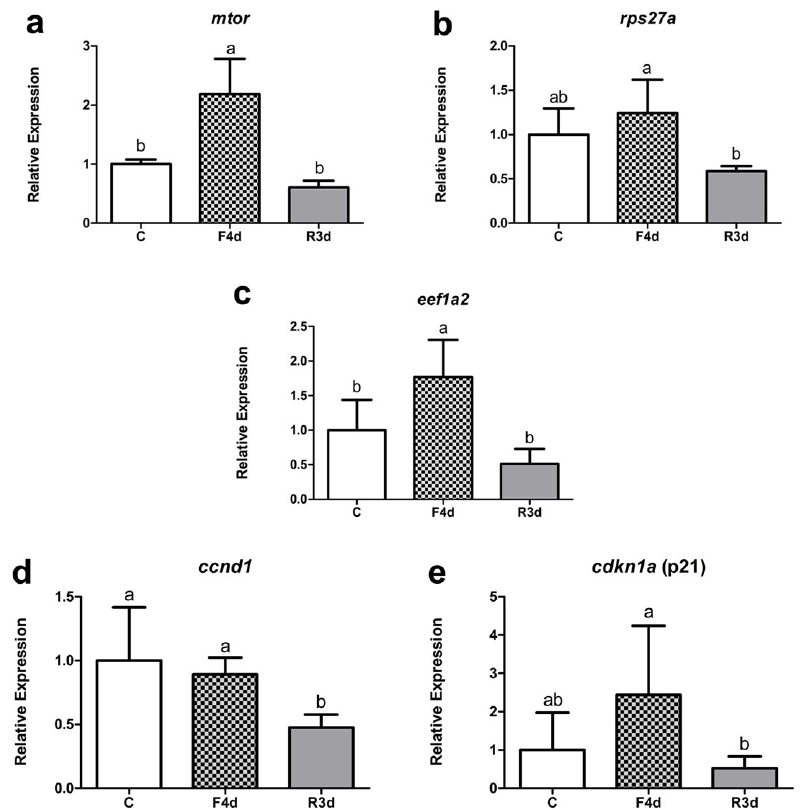
Figure 4. Relative mRNA expression of mtor ( a ), rps27a ( b ), eef1a2 ( c ), ccnd1 ( d ), and cdkn1a ( e ) in early juvenile pacu. The genes were evaluated in the control (C), four-day fasting (F4d), and three-day refeeding (R3d) groups. Data are expressed as the fold change of group C and presented as the mean ± SD. Different letters indicate significant differences between groups ( p < 0.05 in a one-way ANOVA test, followed by Tukey’s multiple comparisons test for mtor , rps27a , ccnd1 , and cdkn1a , or the Kruskal–Wallis and Dunn tests for eef1a2 , n =